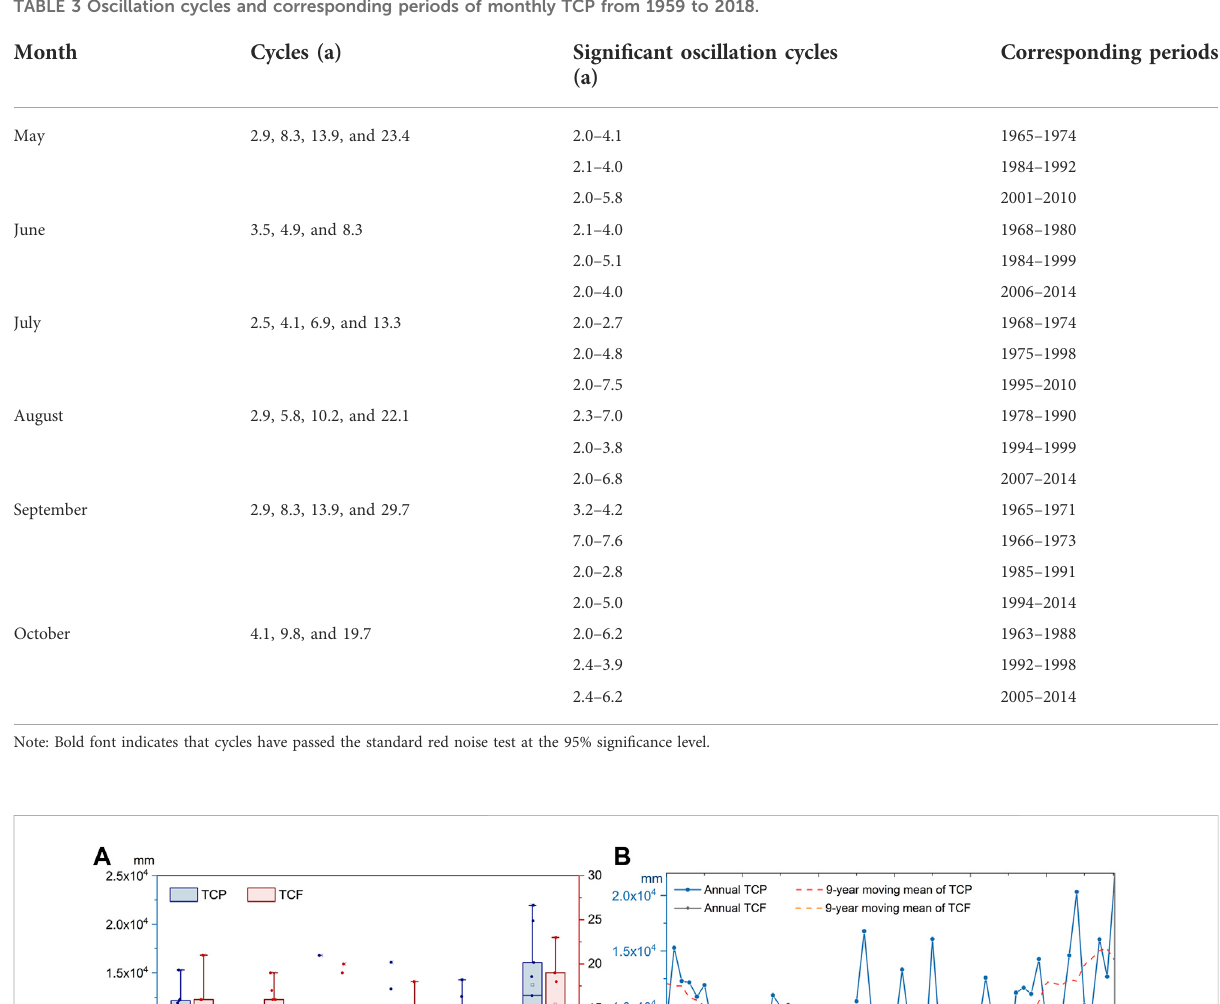
TABLE 3 Oscillation cycles and corresponding periods of monthly TCP from 1959 to